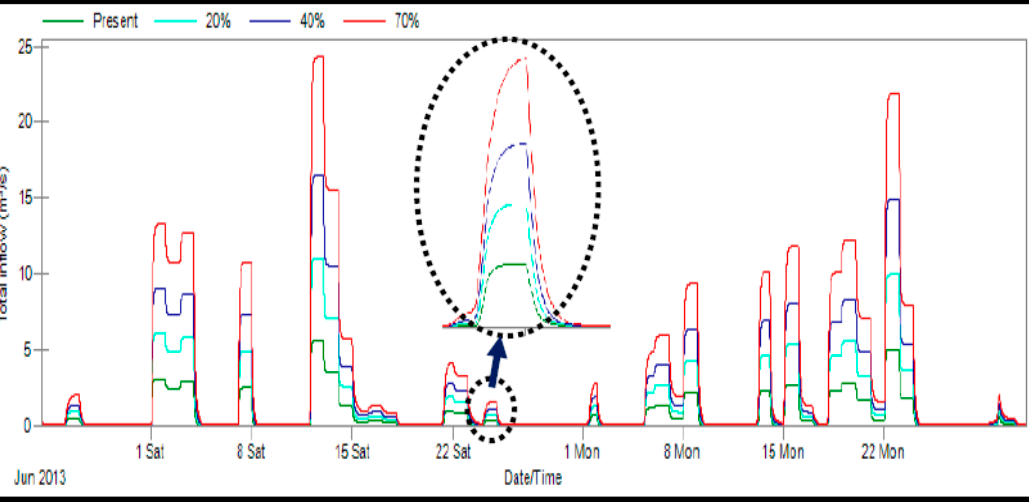
Figure 6. Effects of urbanization on Flow Duration Curve (FDC) in the Myponga catchment.